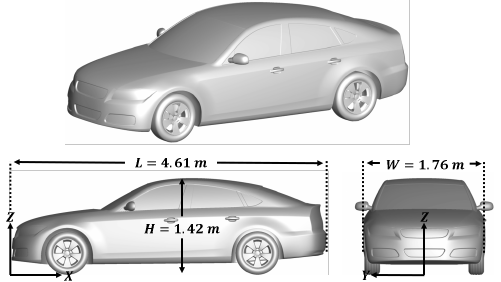
Figure 1. DrivAer fastback